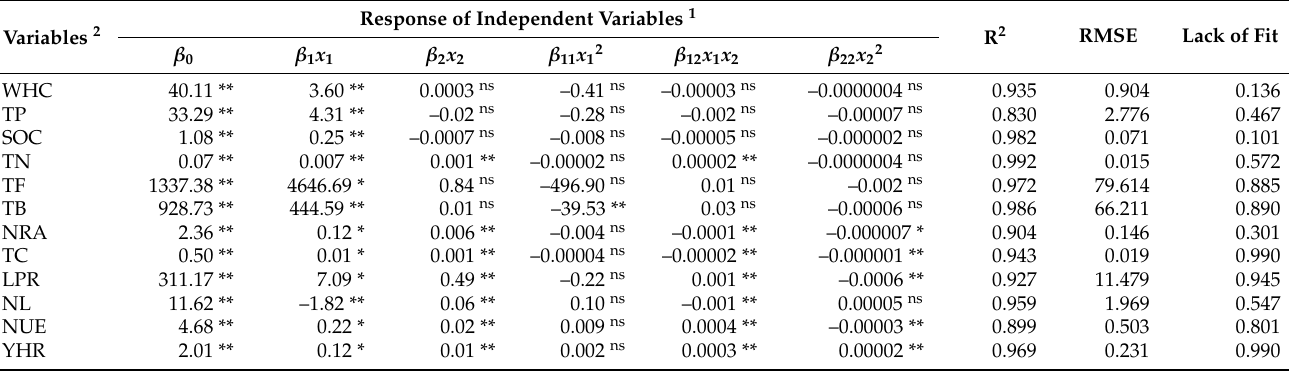
Table 5. Regression coefficients and fitted